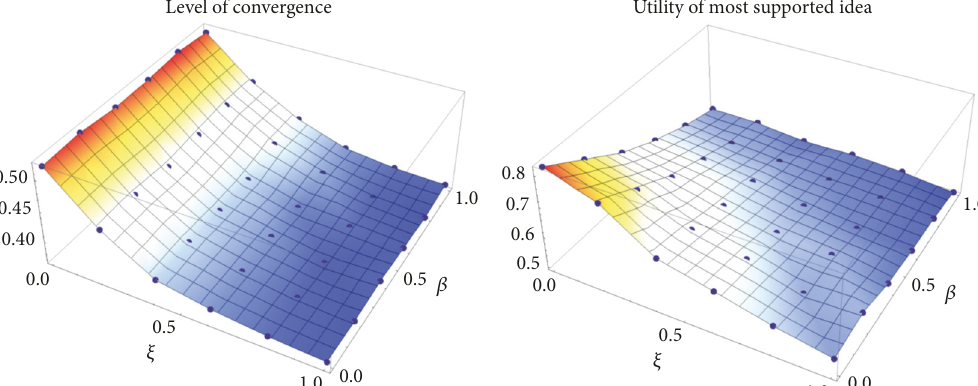
Figure 2: Effects of Within-Group Noise and Group-Level Bias on Decision Convergence and Quality . Note: Effects of within-group noise ( 𝜉 ) and group-level bias ( 𝛽 ) on the level of convergence (left) and the true utility value of the most supported idea (right). Each dot represents an average result of 500 independent simulation